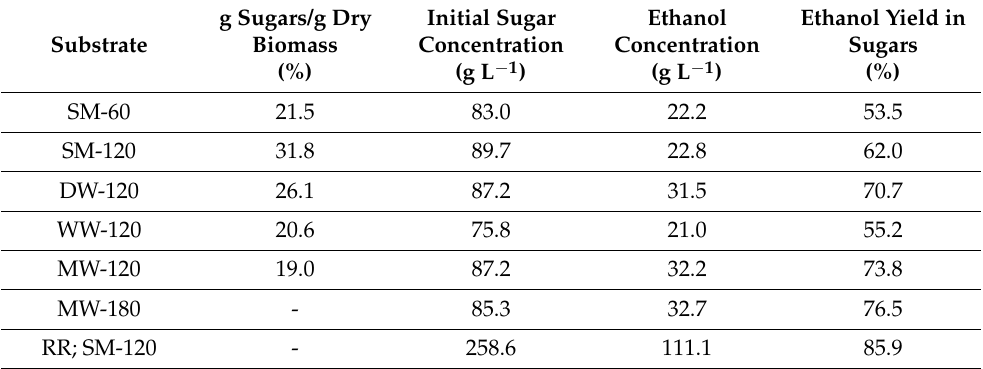
Table 4. Ethanol production and yields from acid pretreatment of biomass from cyanobacteria- based cultures grown on synthetic medium treated for 60 min (SM-60) and 120 min (SM-120), dairy wastewater treated for 120 min (DW-120), winery wastewater treated for 120 min (WW-120), and mixed wastewater (winery and raisin effluents) treated for 120 min (MW-120) and 180 min (MW-180). RR: raisin residue extract. Ethanol Yield in Ethanol Initial Sugar g Sugars/g Dry Sugars Concentration Concentration Substrate Biomass (g L − 1 ) (g L − 1 ) (%)